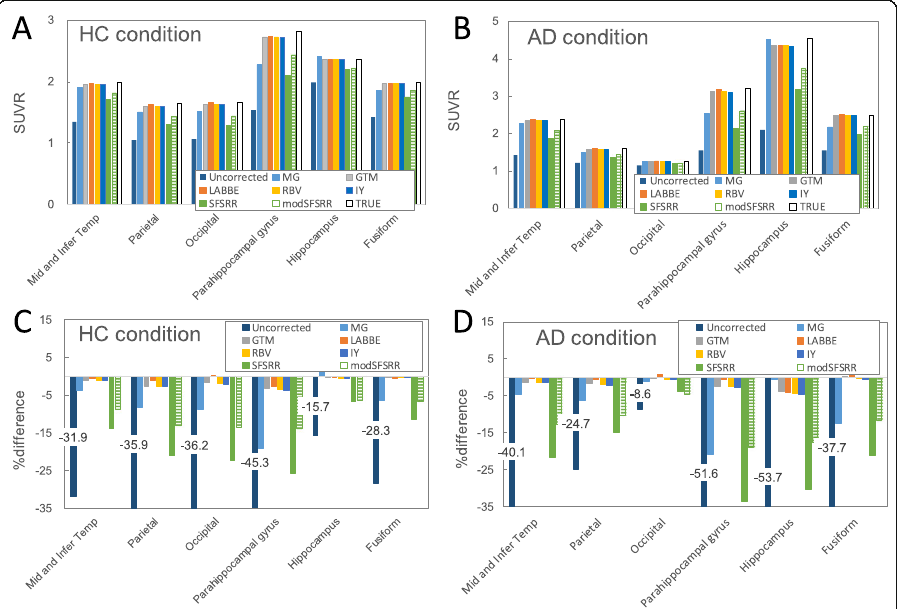
Fig. 3 SUVRs and %difference of pseudo-observed/PVC-SUVRs against true SUVRs. a SUVRs in HC